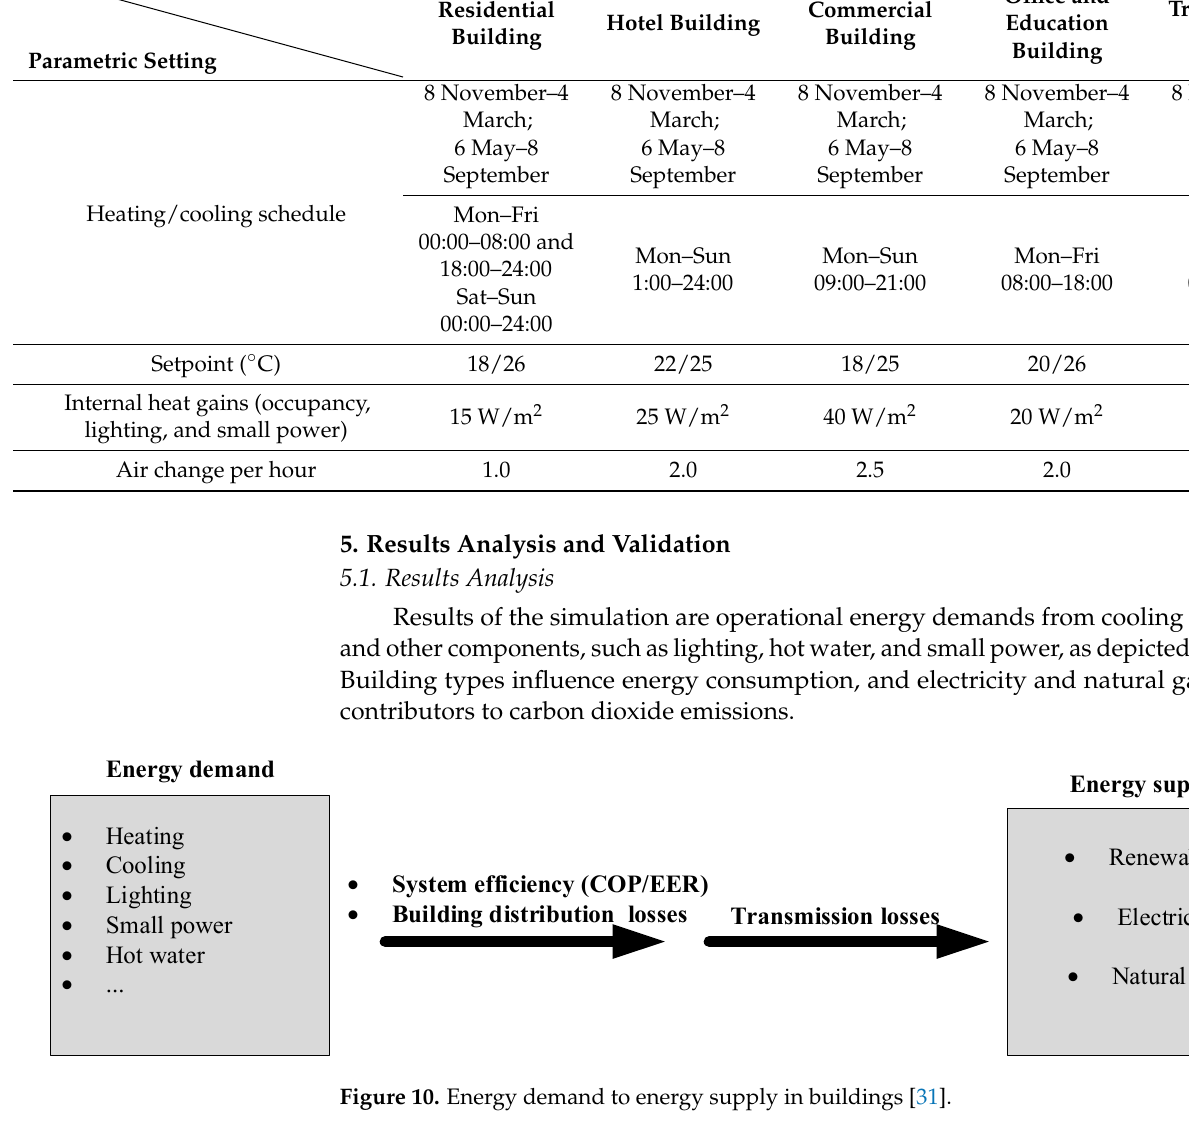
Table 6. Output of annual heating and cooling demands, based on five building